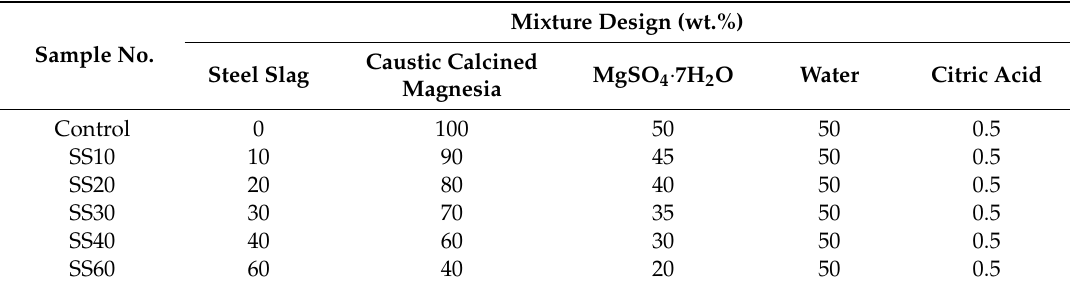
Table 3. Mixture design of magnesium oxysulfate cement